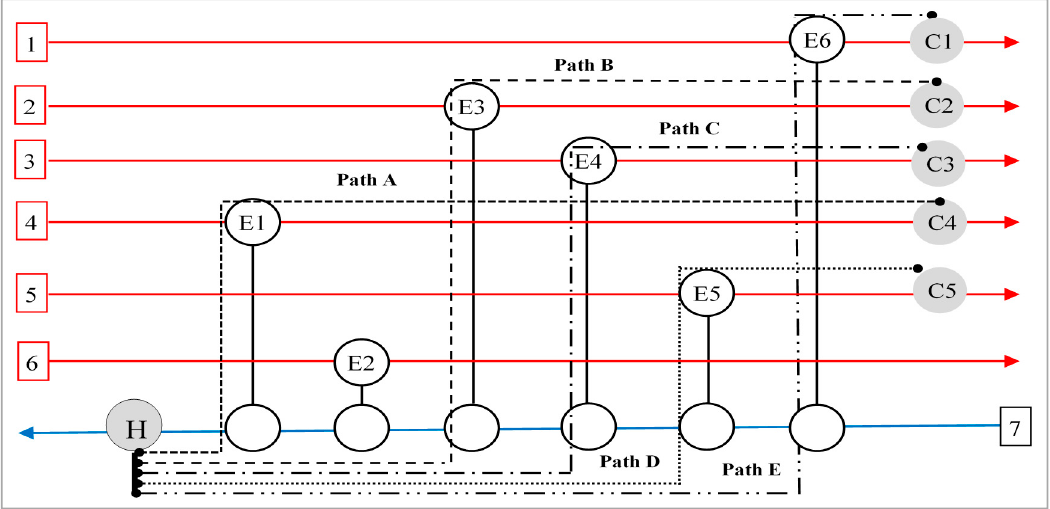
Figure 3. Available individual utility paths in HEN.